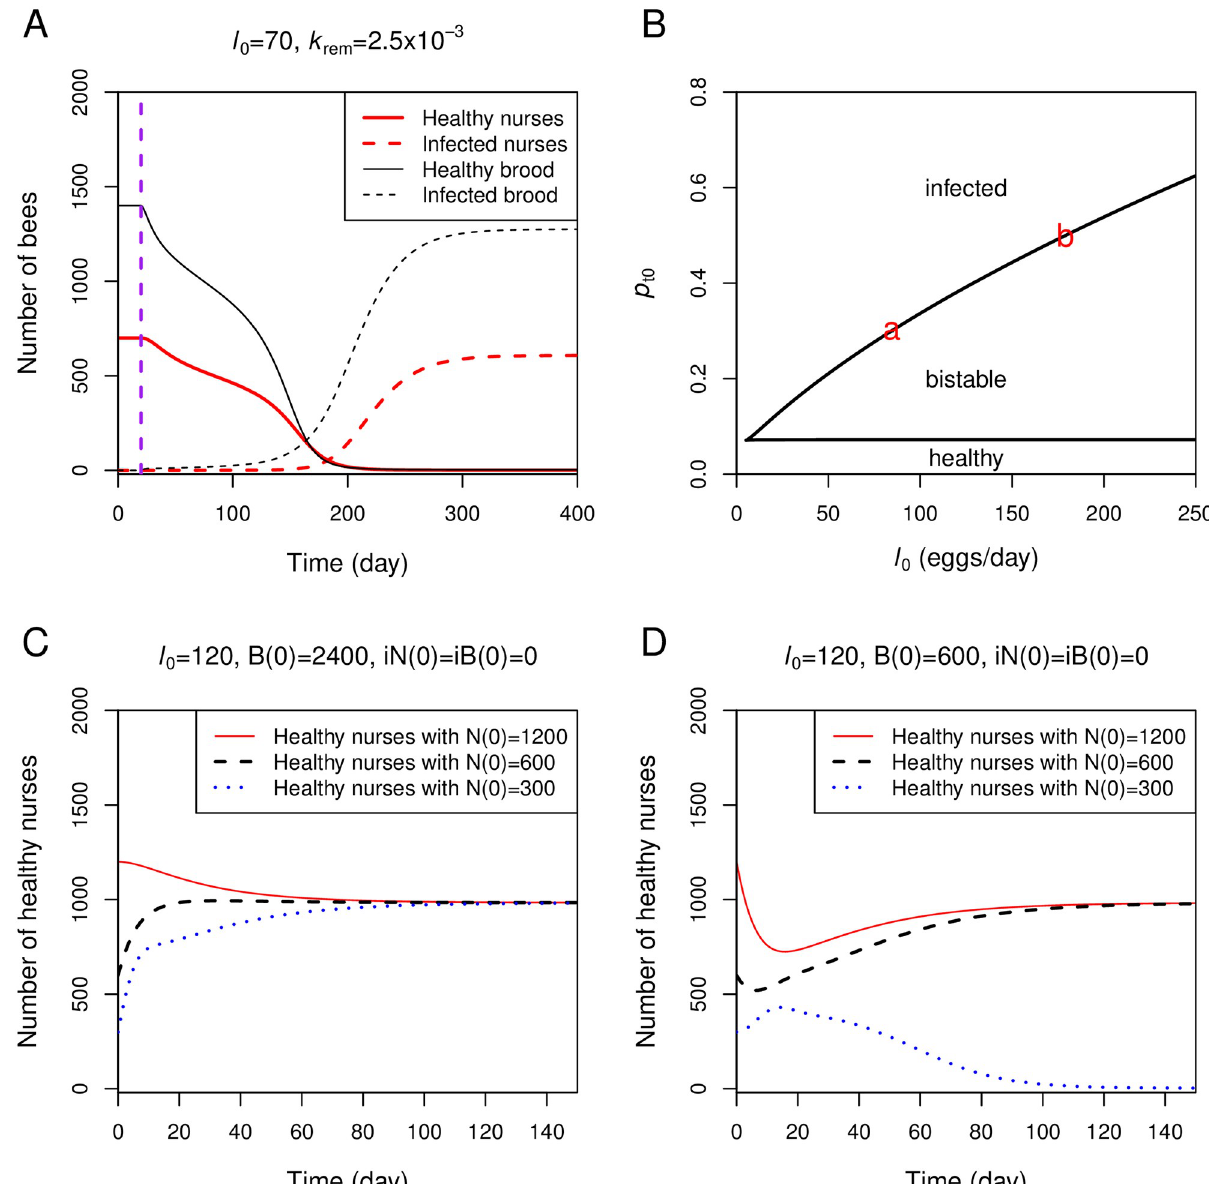
Fig 3. Role of the egg-laying rate ( l 0 ). A: All brood and nurses in a small-size colony (e.g., colony with a low egg-laying rate) become infected even with the hygienic behavior response. The simulation setting is the same as in Fig 2A, except that l 0 = 70. The infection is introduced ( p t1 � k RN � iR 1 = 5 × 10 − 4 ) at day 20 (vertical purple line). B: The two-parameter bifurcation diagram is plotted between l 0 and p t0 while other parameters are fixed. The red letters a and b mark the critical values of l 0 , below which the colonies are always infected when p t0 is 0.3 and 0.5, respectively. C: Simulation of three colonies with the same parameter set from Fig 2A, but the simulation begins with 2400 initial healthy brood and different initial numbers of healthy nurses. The infection is introduced ( p t1 � k RN � iR 1 = 5 × 10 − 4 ) at day 0. D: Simulation setting is the same as that of panel C, except that the initial number of healthy brood is